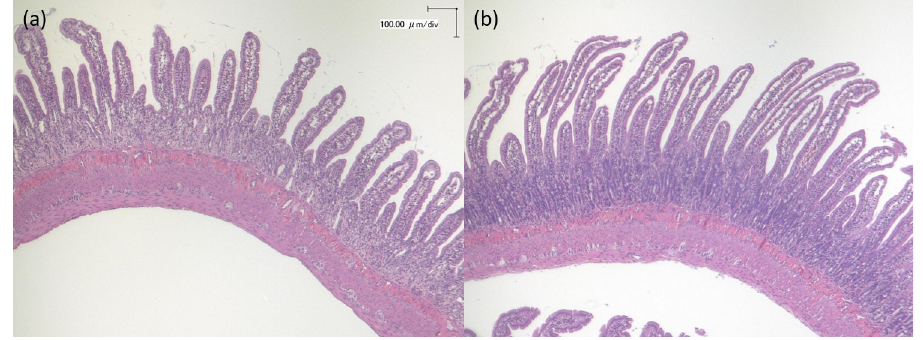
Fig 4. Microscopic features of the jejunum. ( a ) CTR group and ( b ) IMF group.